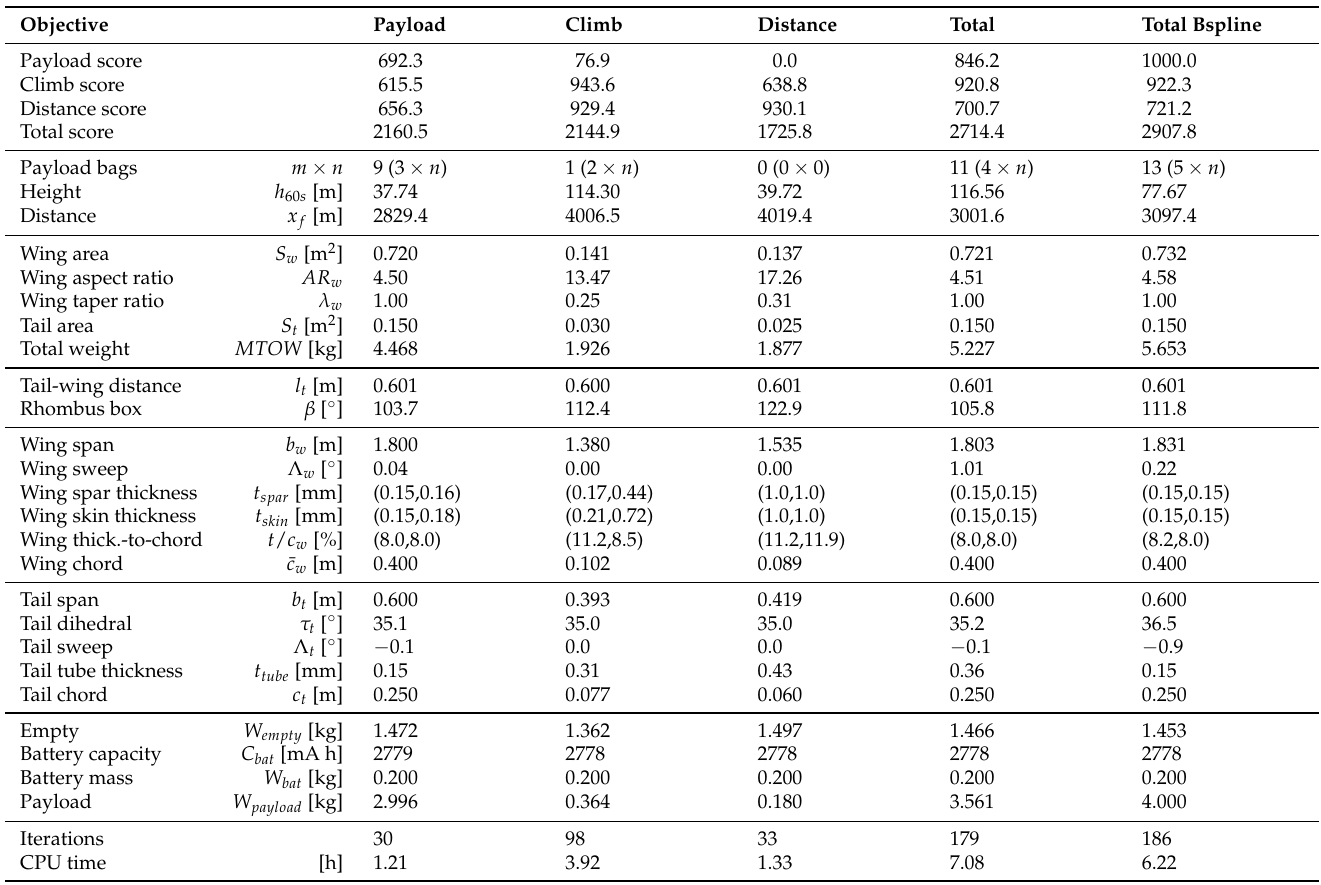
Table 4. Single-and multi-objective